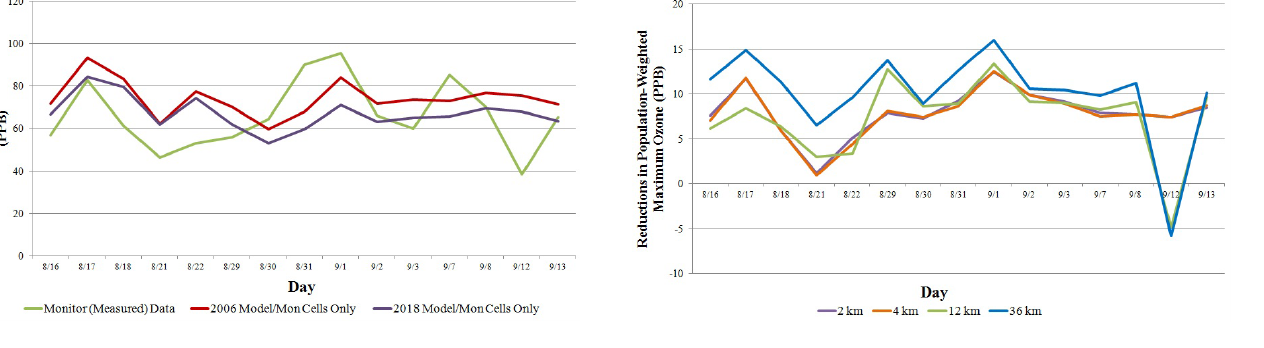
Fig. 5. Impact of 2018 control scenario (2018 Control case – 2006 Base case) on daily maximum 8-h ozone population weighted ozone concentration by resolution using all grid cells within the HGB area. Results are shown for 36km (blue), 12km (green), 4km (orange) and 2km